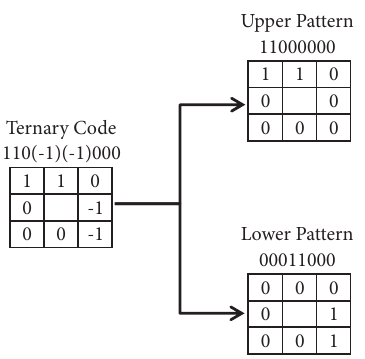
Figure 3: Demonstration of the LTP texture descriptor.